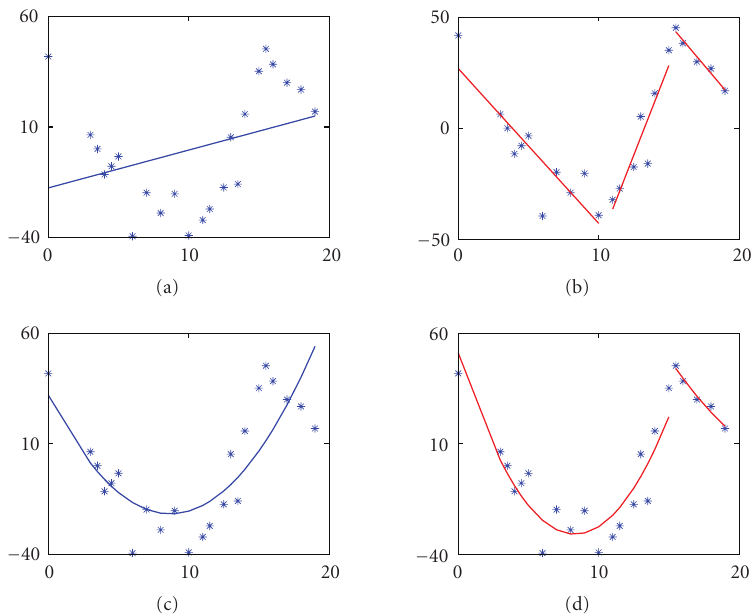
Figure 2: Examples of fitting the variation of the ratio feature. The horizontal axis represents the skeletal age and the vertical axis corresponds to the values of the feature.